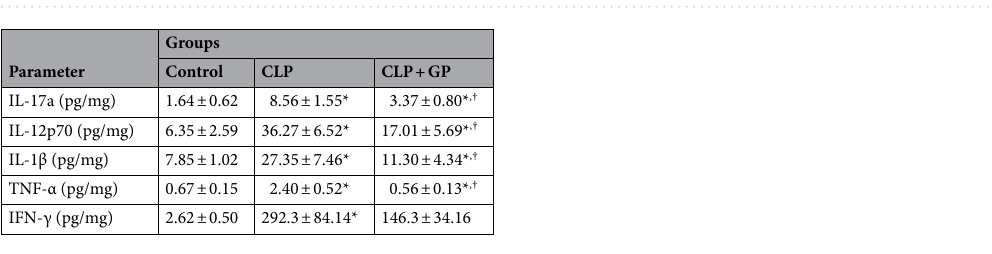
Table 2. Renal tissue levels of cytokines. * p < 0.05 versus control; † p < 0.05 versus CLP.